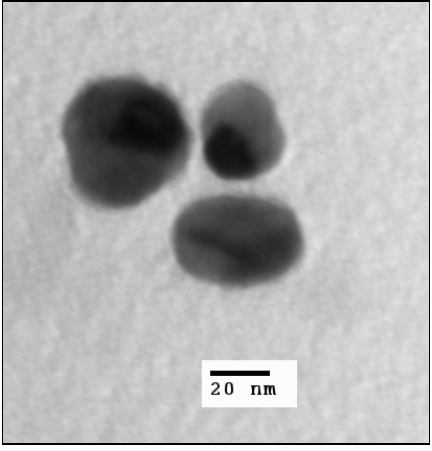
Figure 1. TEM image of 40 nm gold nanoshells.